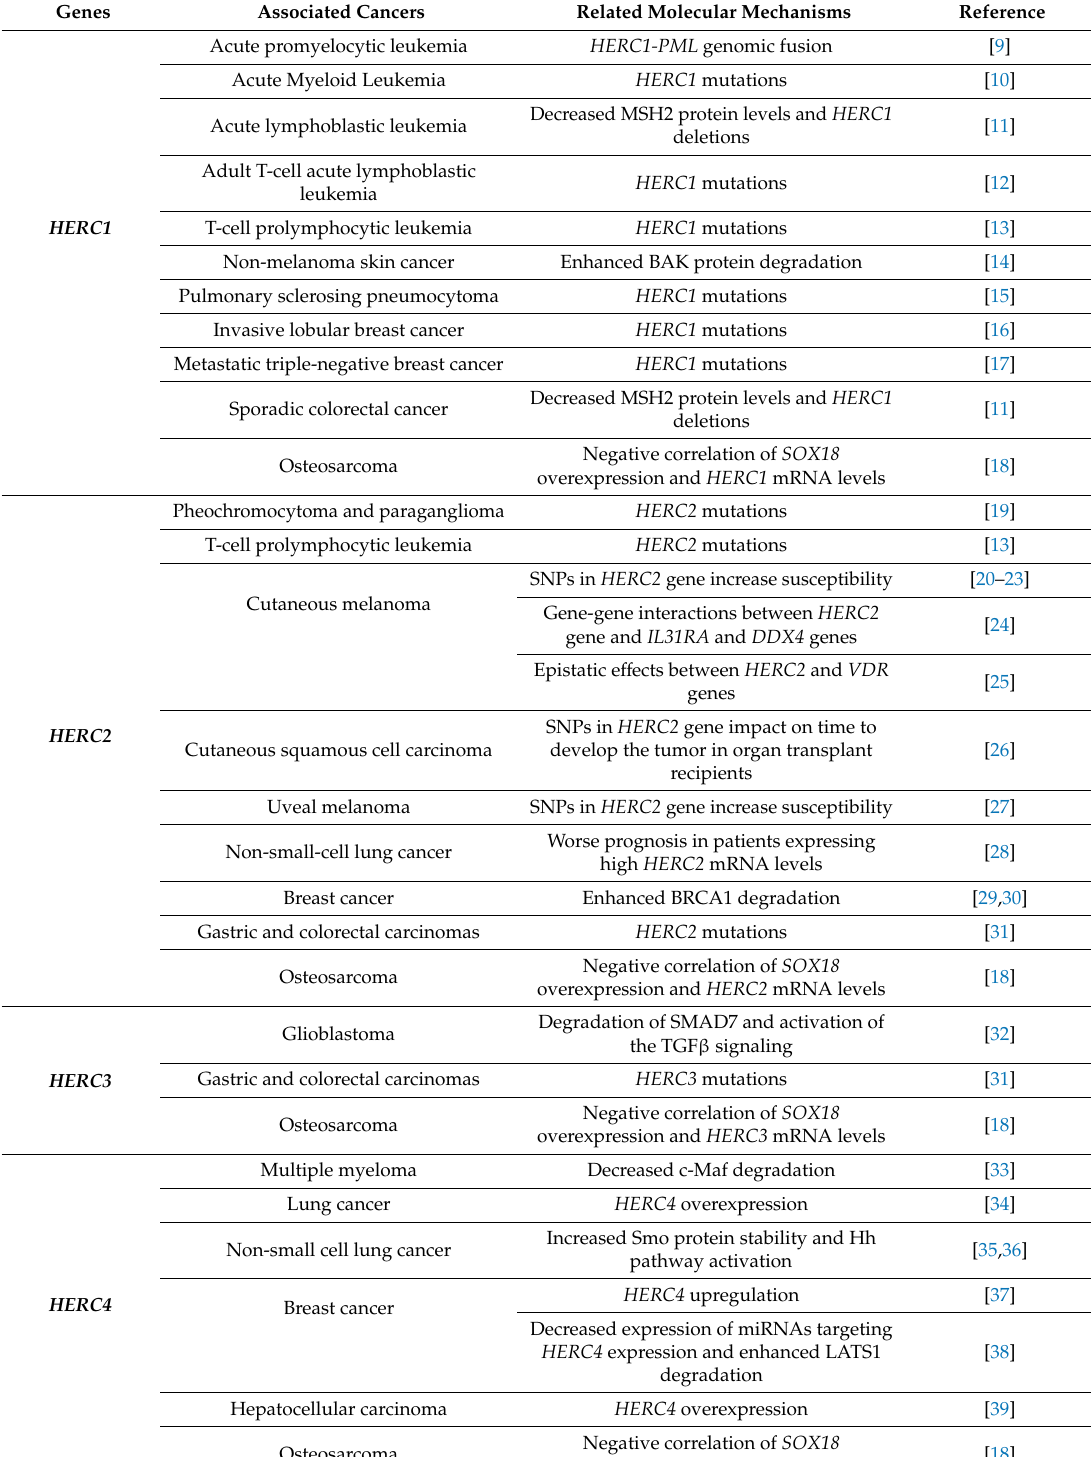
Table 1. Cancers associated with HERCs and related molecular